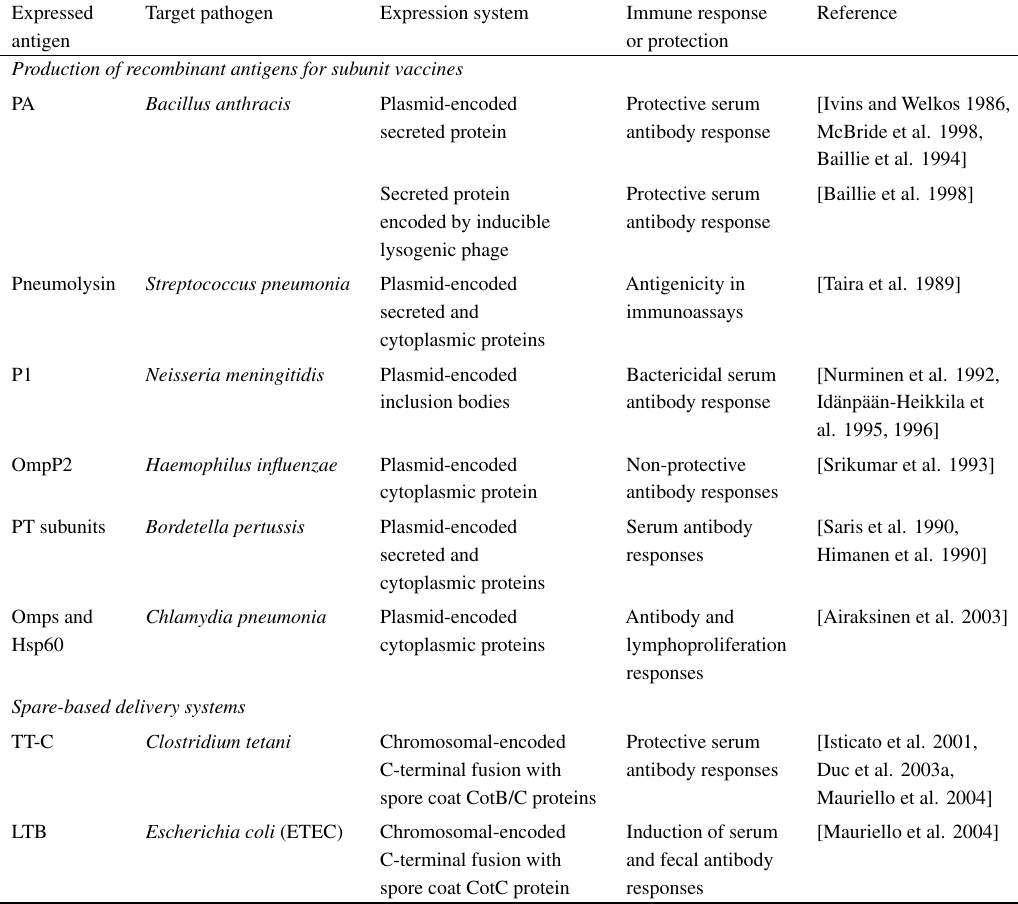
Antigens expressed by recombinant B. subtilis strains aiming the production of